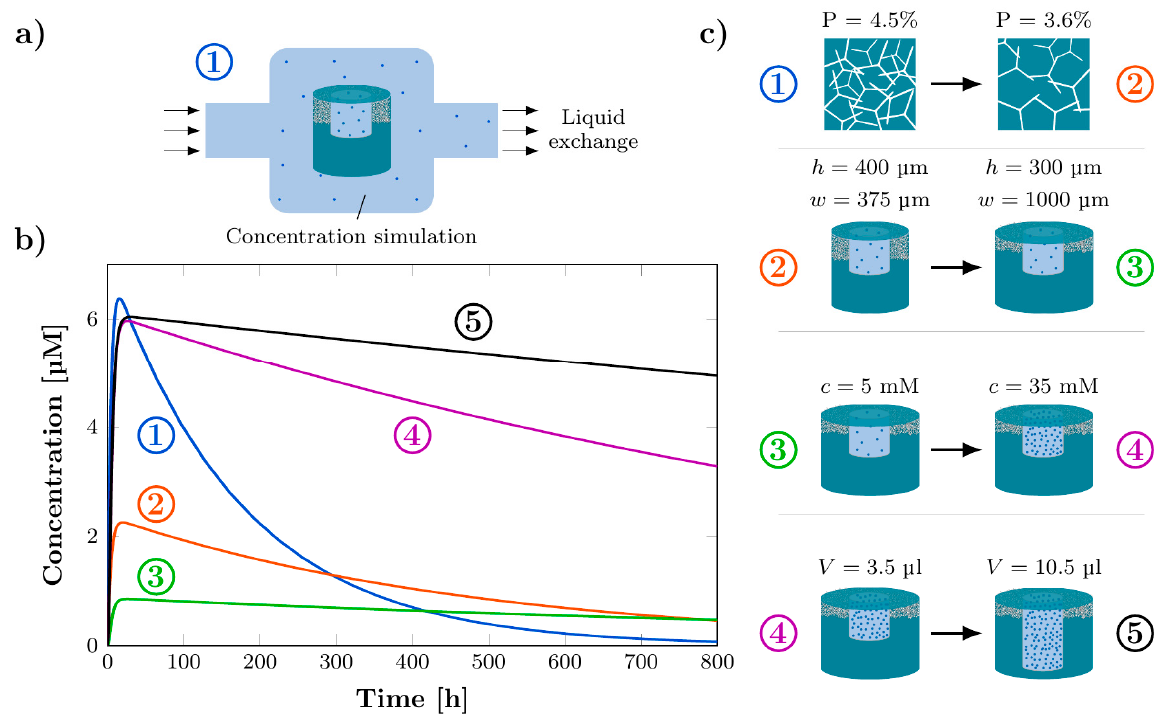
Figure 8. Computational simulation of concentration profiles for exemplary in vivo conditions. ( a ) Schematic of the rDDS inside the tumor cavity releasing the drug, which is transported out of the cavity by the exchange of liquid. ( b ) Simulated concentration profiles for varying parameters. Start- ing from the standard rDDS (compare Table 1), with 5 mM initial concentration, for the respective subsequent concentration profile, a certain parameter was changed, compared to the previous one. The numbering indicates the order of parameter changes. ( c ) Schematic of the respective parameter changes from one concentration profile to the subsequent one.